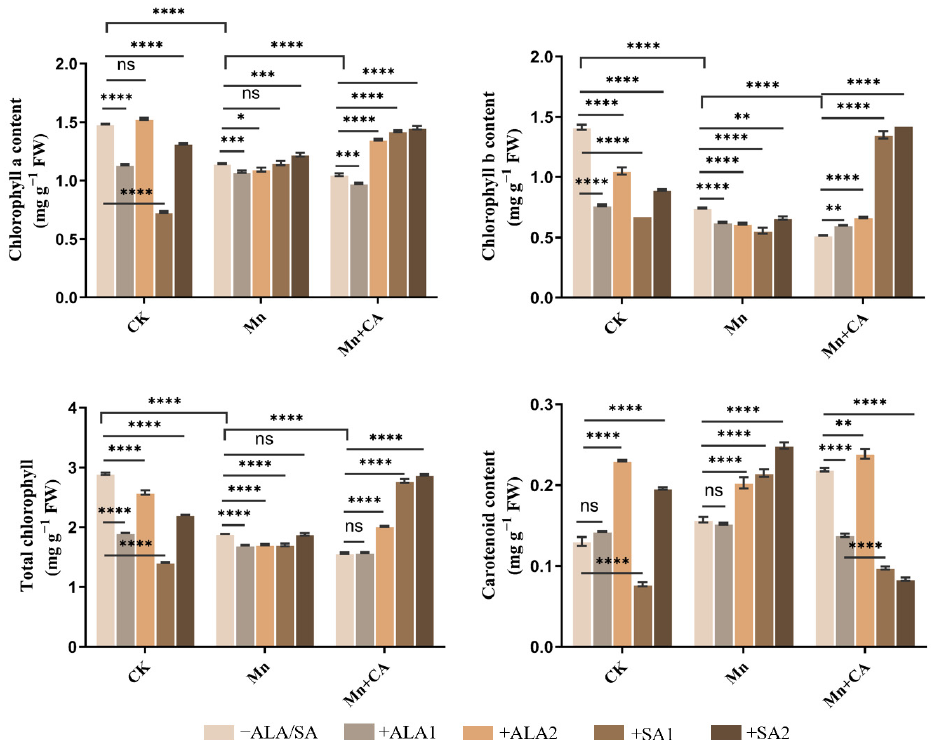
Figure 1. Effects of 5-aminolevulinic acid or salicylic acid (ALA/SA) combined with citric acid (CA) on chlorophyll a, chlorophyll b, total chlorophyll and carotenoid contents under manganese (Mn) treatment in sunflower plants. CA means 20 mmol kg − 1 citric acid treatment. ALA1/ALA2 indicates spraying with 10/20 mg L − 1 ALA. SA1/SA2 indicates spraying with 50/100 mg L − 1 SA. CK, control plants without any treatment; Mn means that plants were exposed to 0.8 g kg − 1 Mn for 7 days; Mn + CA indicates plants treated with CA for 7 days after Mn treatment. Mn + CA + ALA/SA treatment indicates plants treated with ALA/SA for one week after CA treatment. Note: Data are the means of three replicates (mean ± SE). * indicates a significant difference at p -value < 0.05, ** p -value < 0.01, *** p -value < 0.001, **** p -value < 0.0001; ns indicates no significant difference according to Tukey’s multiple comparisons